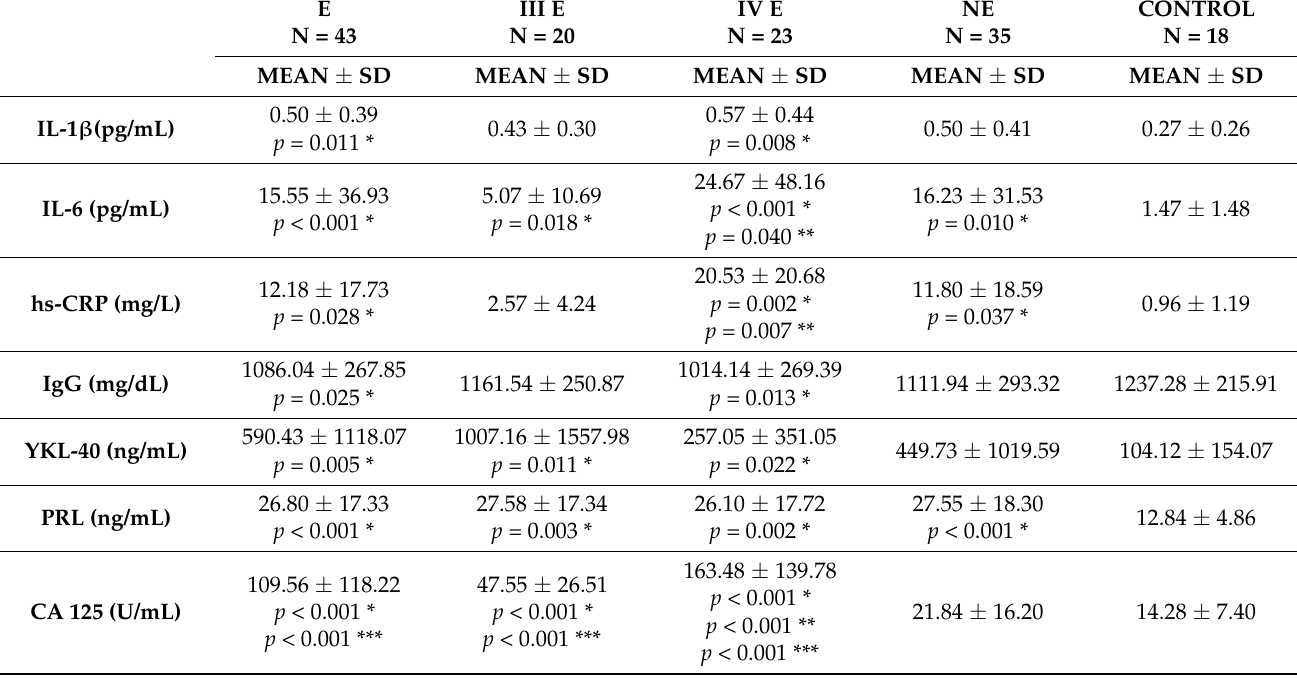
Table 1. The concentrations of selected parameters in the studied